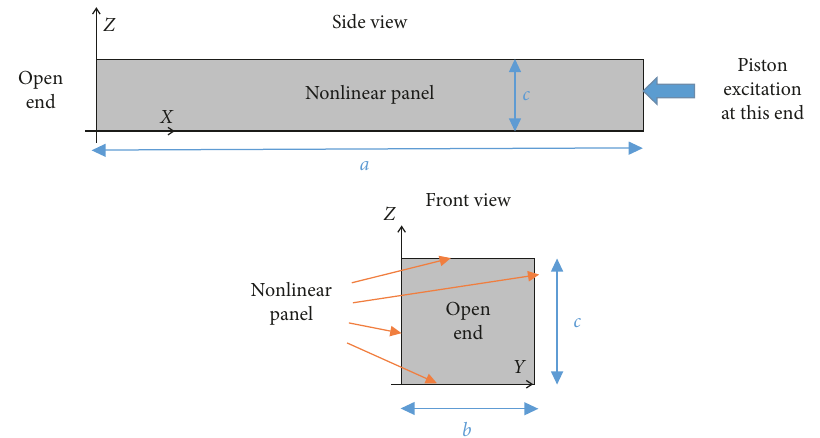
Figure 1: A duct/tube formed by nonlinear flexible